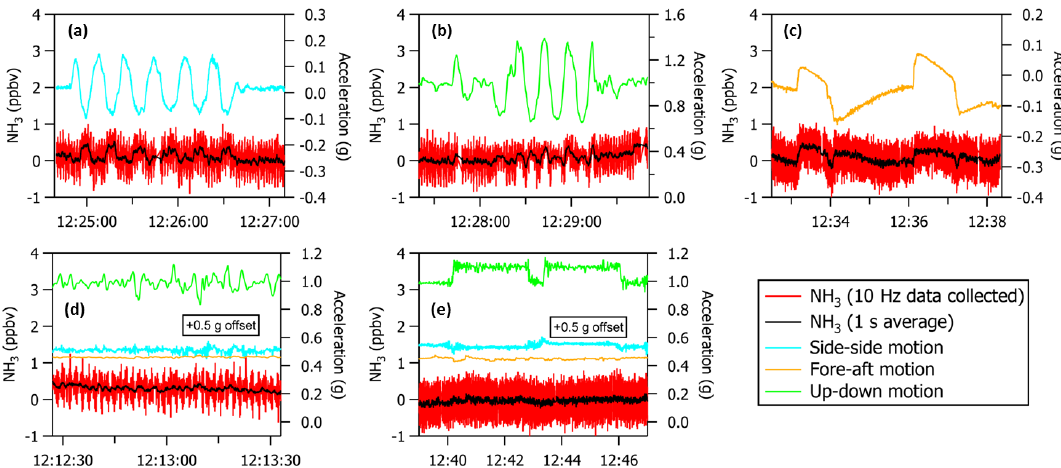
Figure 4. Maneuvers performed at 2.6kma.g.l. in flight while overblowing the inlet tip with NH 3 -free air show changes in NH 3 zero signal (in units of ppbv) with respect to aircraft accelerations (in units of g) in the (a) side–side, (b) up–down, and (c) fore–aft motions. Changes in NH 3 zero signal associated with (d) turbulence in the mixed boundary layer at 0.3kma.g.l. and (e) during turns at 2.6kma.g.l. are < 50ppt when scaled by the (cid:49) NH 3 g − 1 observed in each individual dimension during maneuvers. Side–side and fore–aft accelerations are offset by + 0 . 5g for display purposes in panels (d) and (e)